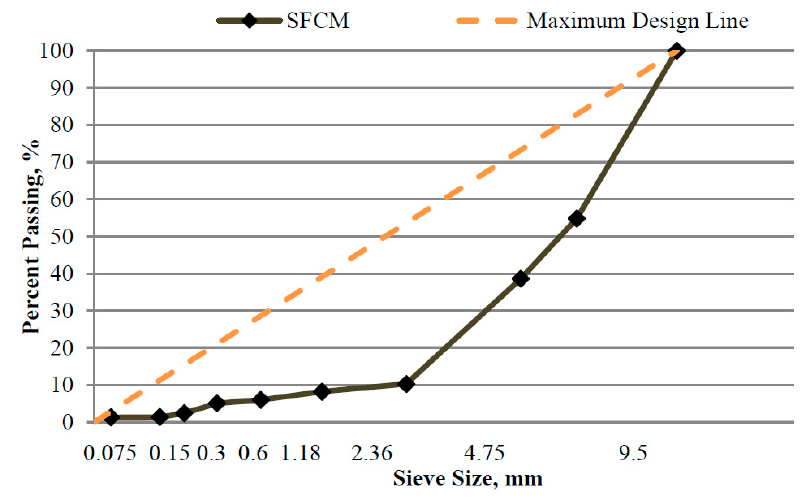
Figure 1. Aggregate gradation of asphalt mixture.